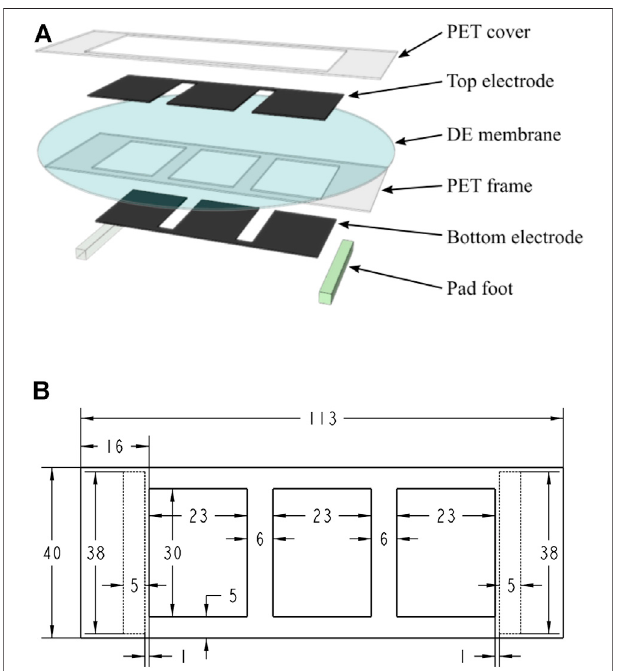
FIGURE 8 | Design of the robot prototype. (A) Exploded view of the robotshowingthemultilayeredDEAstructure; (B) designparametersusedfor the PET frame and pad-feet (pad-feet shown as dashed line) (dimensions in [mm]).